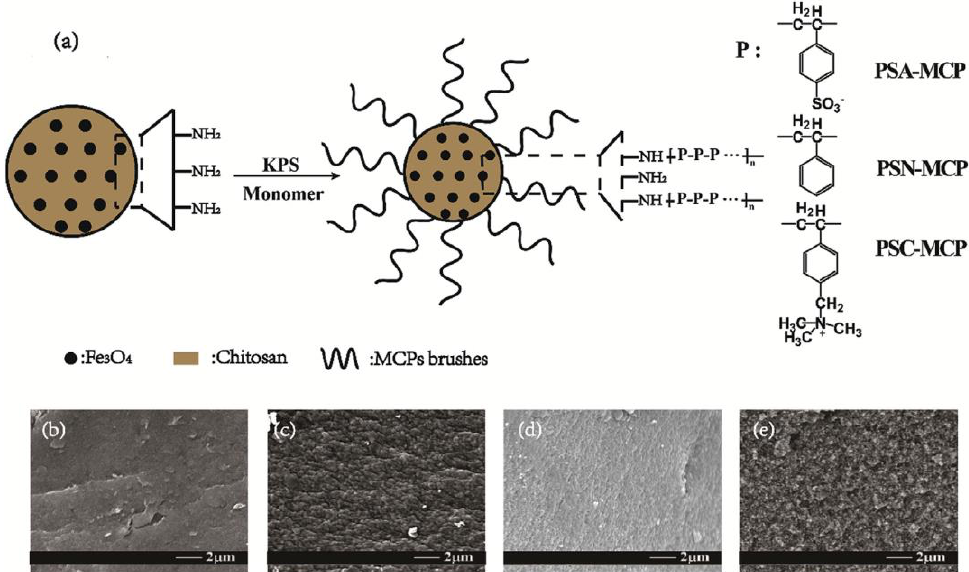
Figure 4. ( a ) Synthetic route; SEM images of ( b ) CS-MCP, ( c ) PSA-MCP, ( d ) PSN-MCP, and ( e ) PSC-MCP [21].